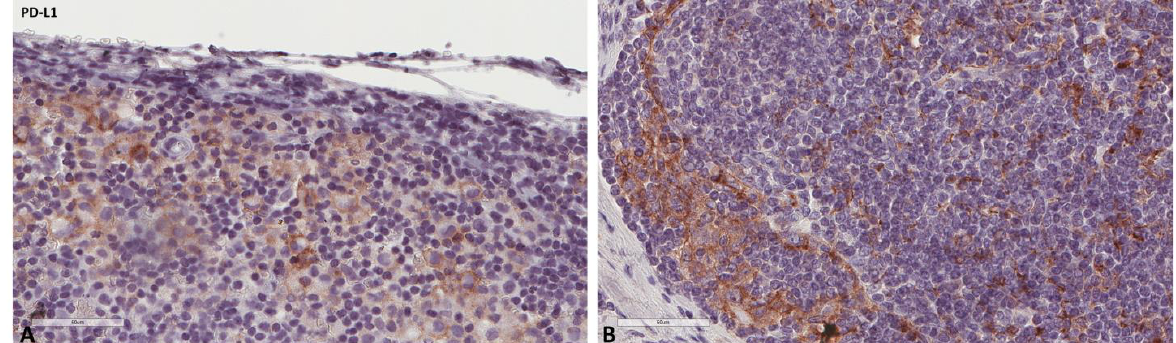
Figure 4. Representative microscopic images of PD-L1 expression in a normal cancer-draining lymph node ( A ) and a normal non-cancer-draining lymph node ( B ).